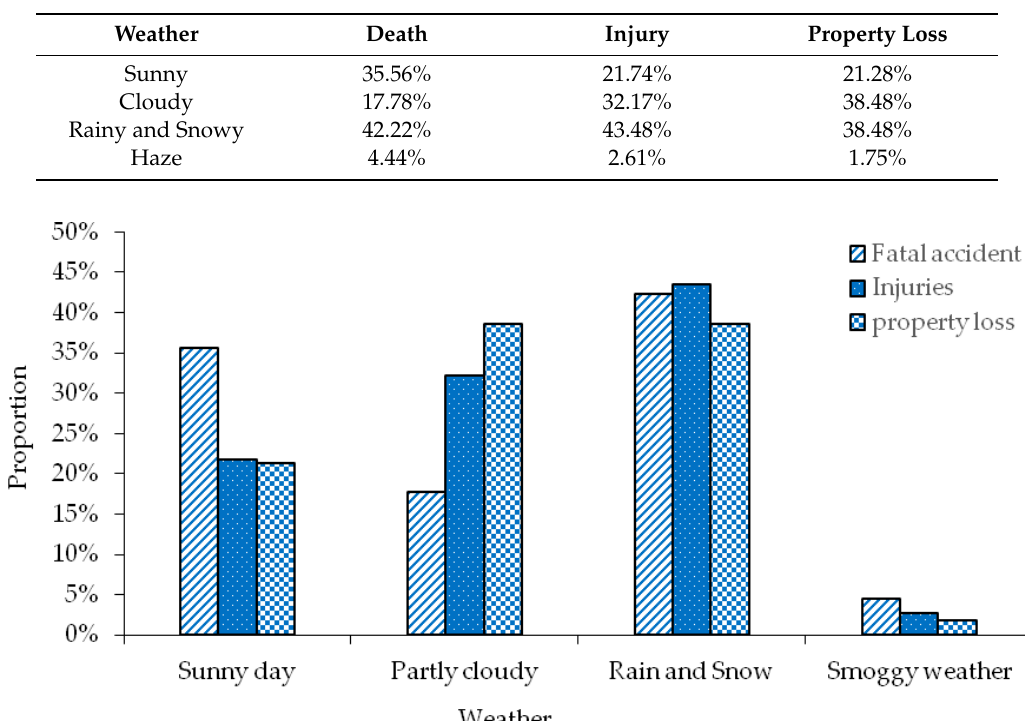
ffi c accidents with weather sub-independent Figure 9. Graph of proportion of traffic accidents with weather sub-independent variables. Figure 9. Graph of proportion of tra